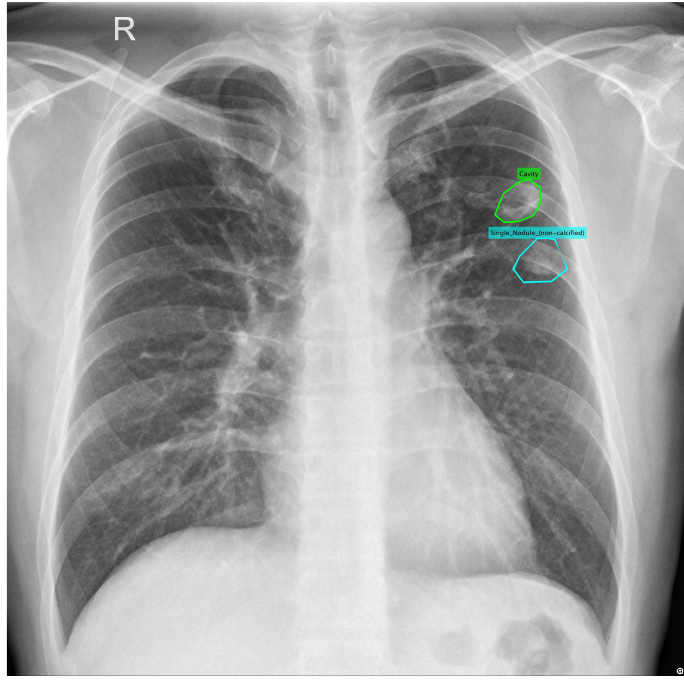
Figure 1. Example of a lung segmentation for a nodule and a cavity.